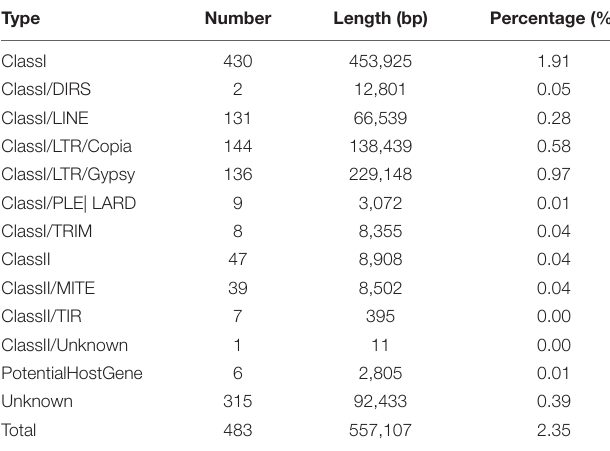
TABLE 4 | Statistics of repeat sequence classification results.